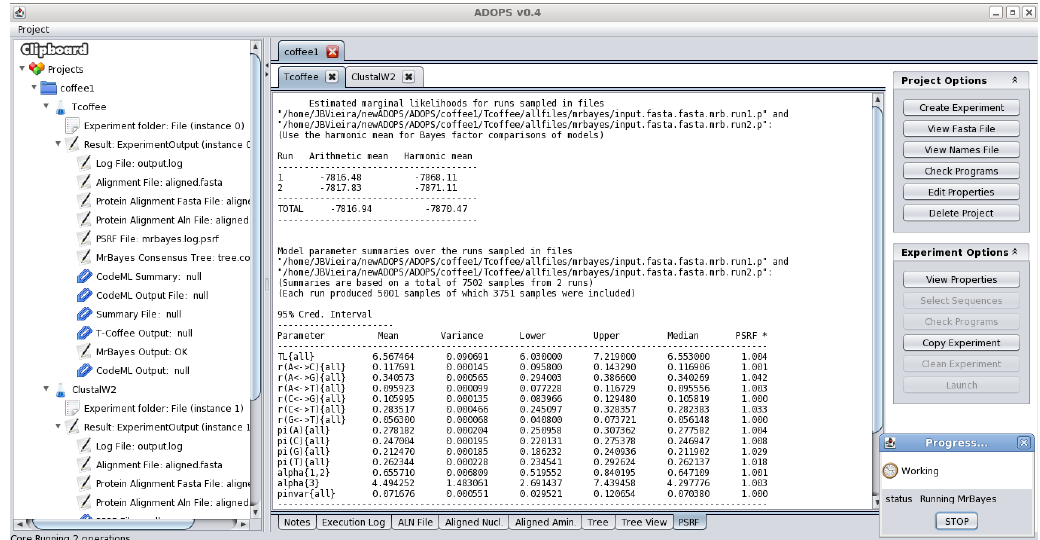
Figure 2: ADOPS graphical user